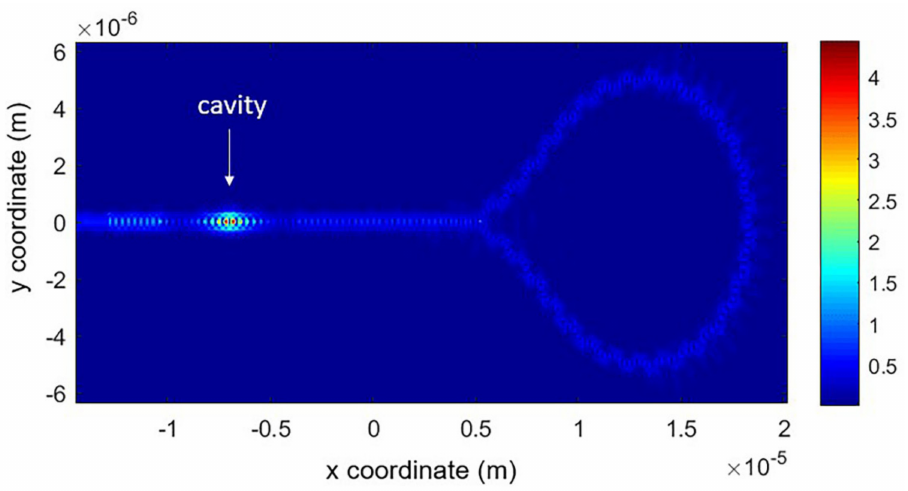
Figure 8. The electric field map of a 1D PhC cavity structure with an ELM at resonance